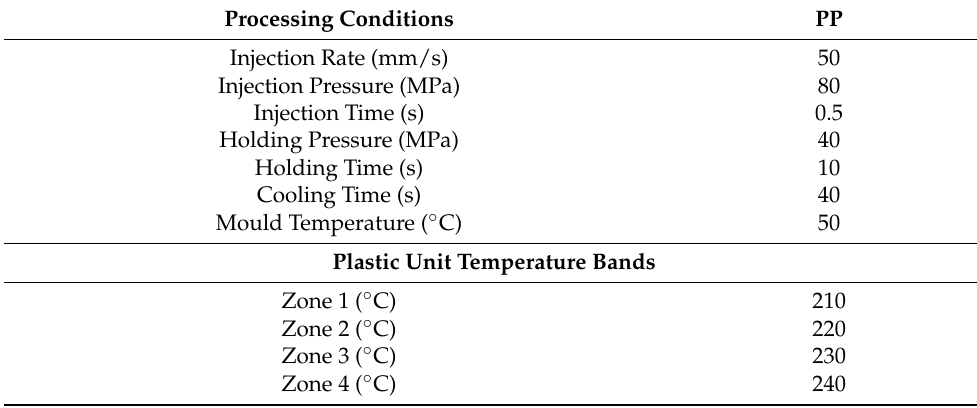
Table 1. Injection molding